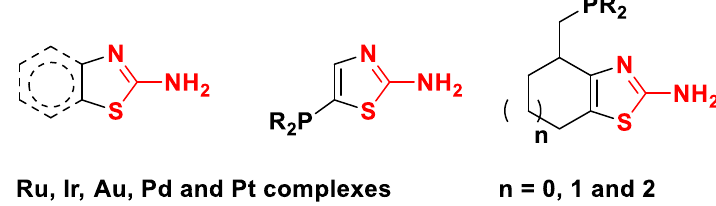
Figure 11. Chemical structures of modified benzothiazolamines.